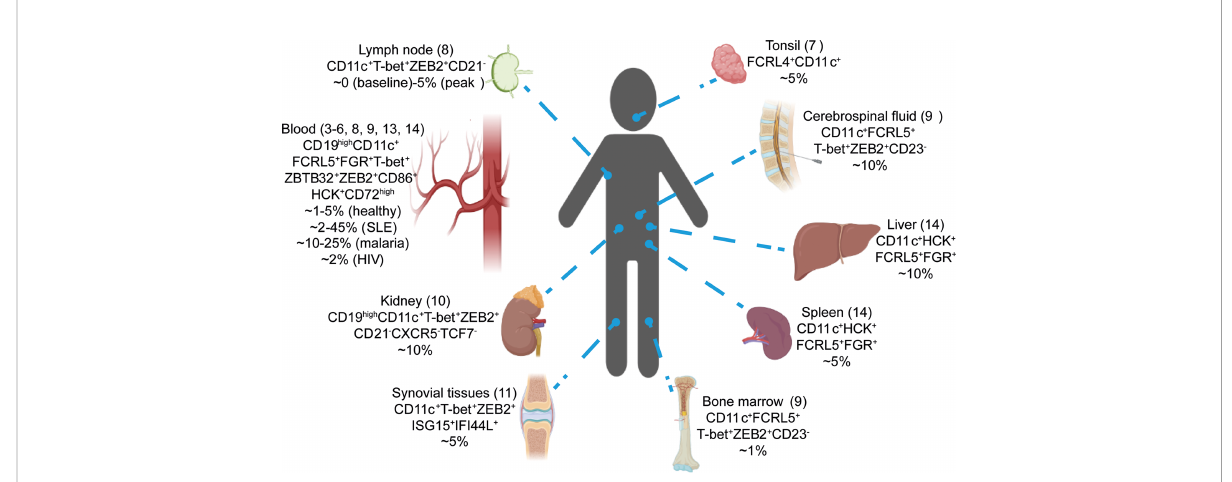
FIGURE 1 scRNA-seq revealed the conserved presence of ABCs in human. Single-cell RNA-seq studies have identi fi ed ABCs in numerous tissues by unsupervised clustering (3-14). Tissues, signature genes and estimated percentages in total B cells for ABCs cluster are